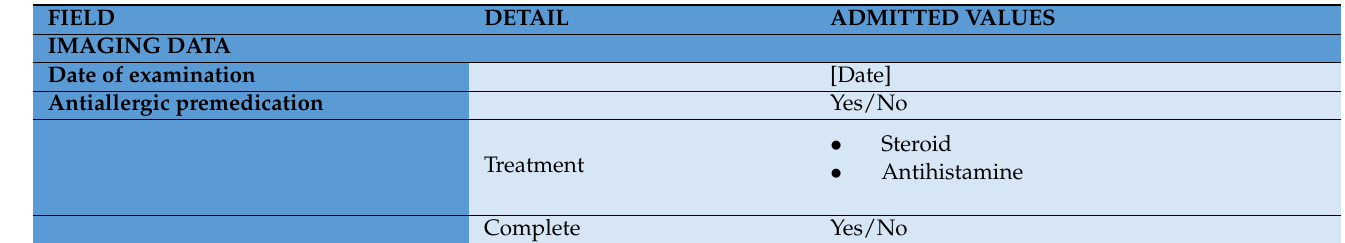
Table A10. IMAGING